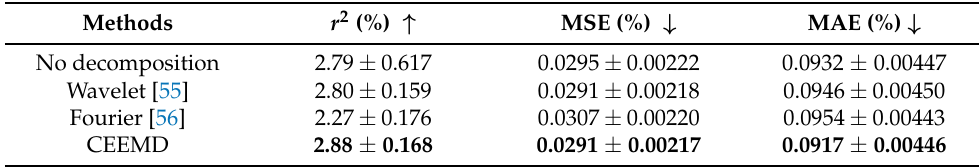
Table 3. Performances of FDG-Trans with different frequency decomposition methods. The results are trained based on MSE loss function.